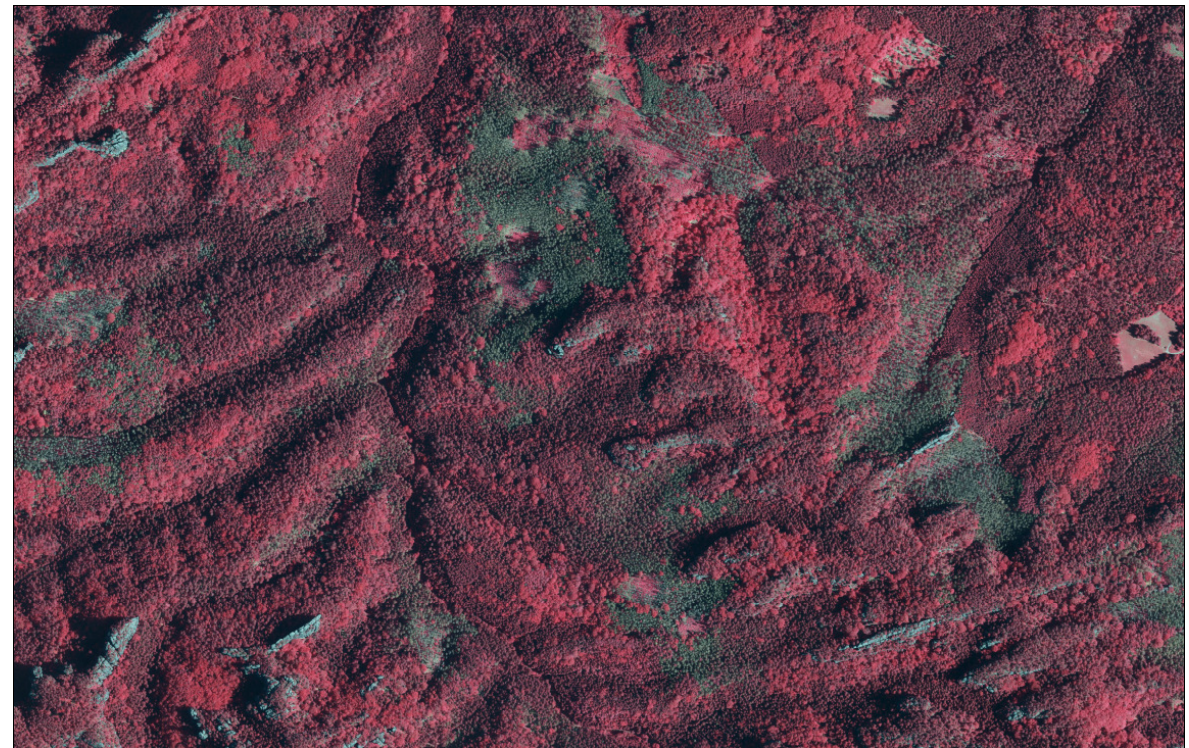
Fig 9: Ortho photo National Park „Sächsische Schweiz", obtained and processed by Hansa Luftbild (reddish: healthy stands; grey: infested